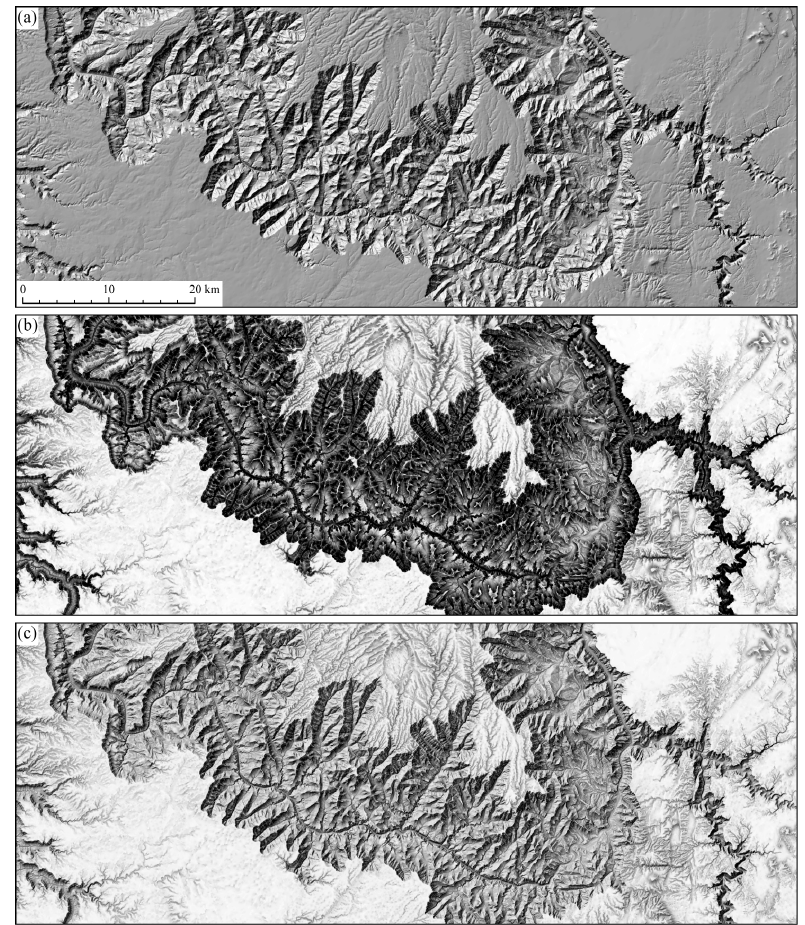
Figure 9. Even though the rugged relief is appropriately represented by hill-shading, as shown in (a) , the legibility of its features is enhanced with the use of SVF (b) , and even more so when both methods are combined (c) . The combination is especially suitable for cartographic purposes. Grand Canyon, Arizona, USA. Data source USGS (1” NED). SVF was computed in 16 directions with a 300 m search